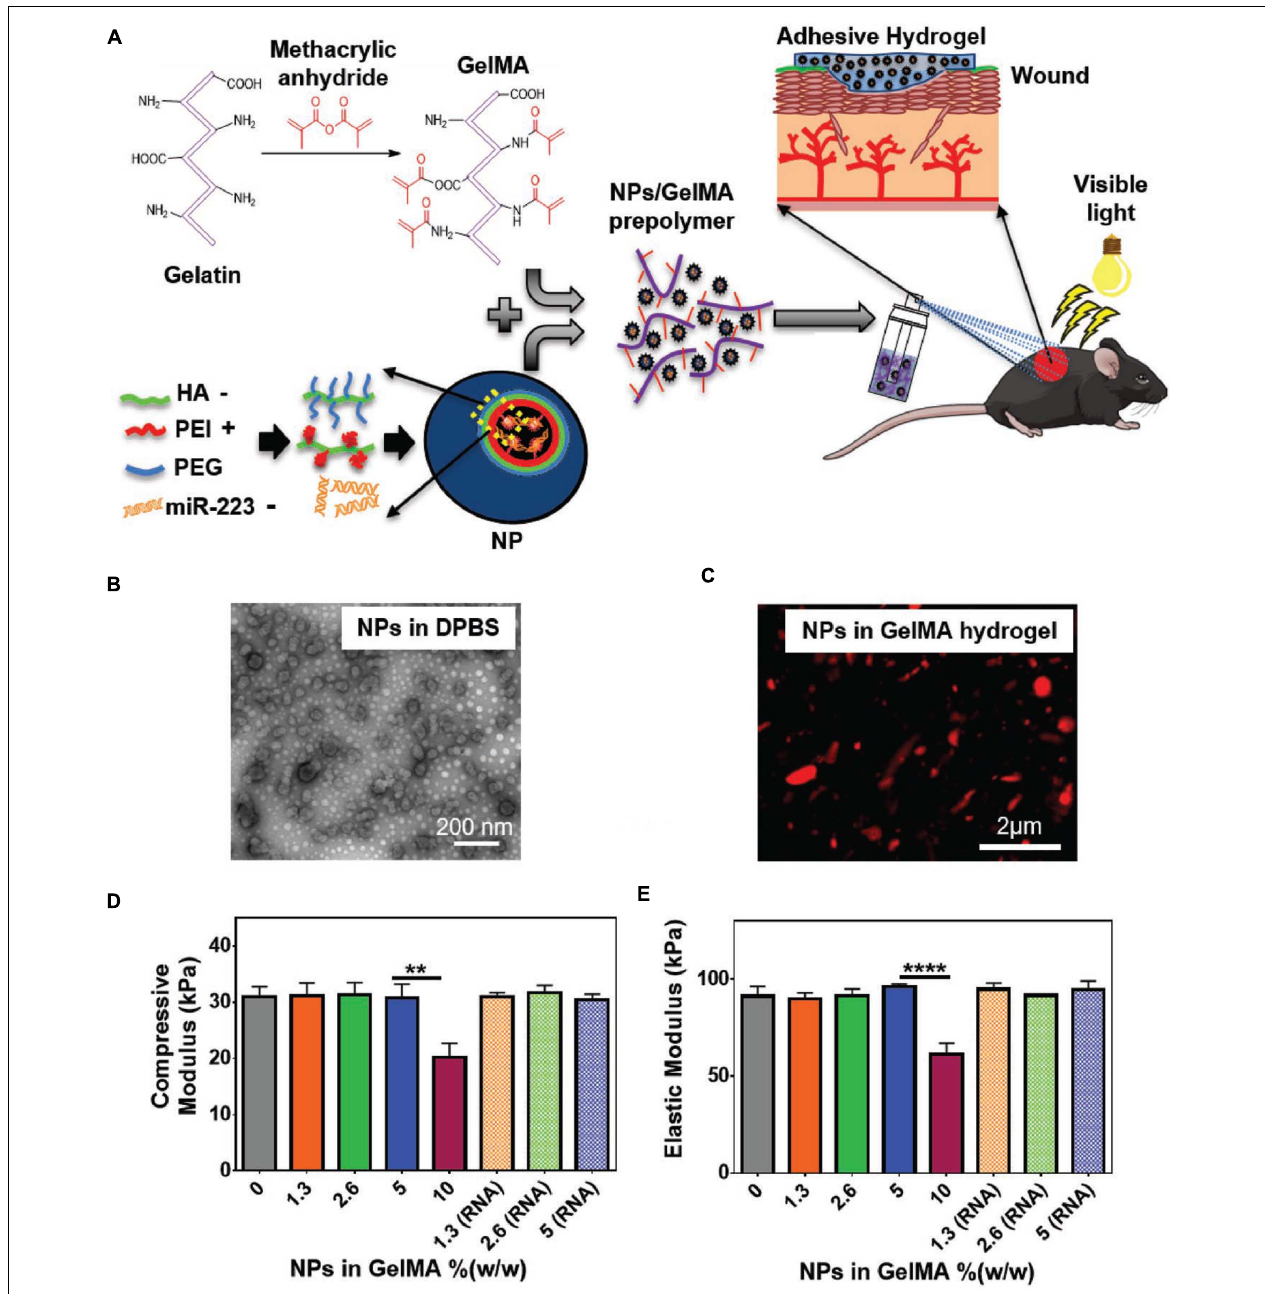
FIGURE 6 | Application of adhesive tissue engineering scaffolds (ATESs) in skin tissue repair. (A) GelMA hydrogel formation and application to skin wounds. (B) Representative TEM image of HA/miR-223 ∗ NPs with ratio of 325:1 (w/w) in DPBS. (C) Representative confocal image of Cy5.5-labeled (red) NPs in hydrogel. (D) Elastic modulus of hydrogels containing different NP concentrations. (E) Compressive modulus of hydrogels with different NP concentrations. ** P < 0.01 and **** P < 0.0001. Reconstructed with permission from Saleh et al. (2019).